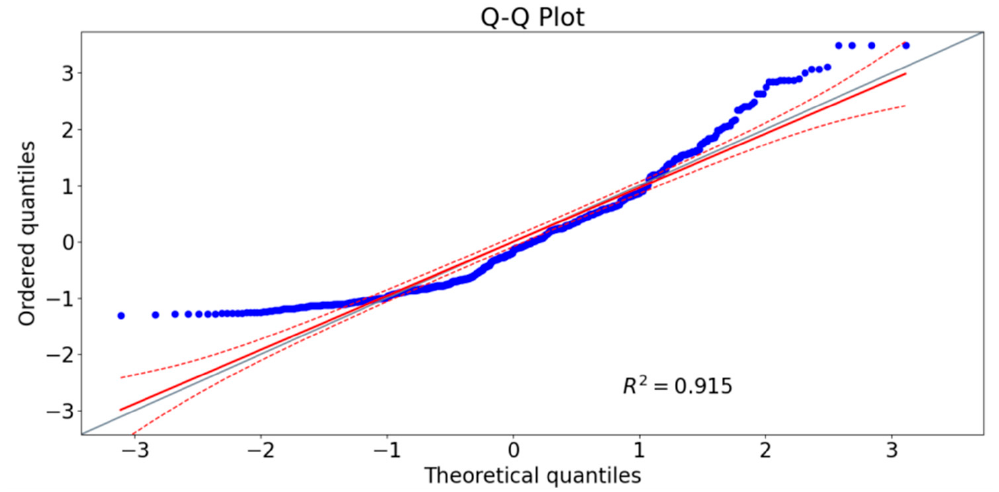
Figure 20. QQ plot of residential sales and revenue loss (the red dashed line represents 95% confi- dence interval).